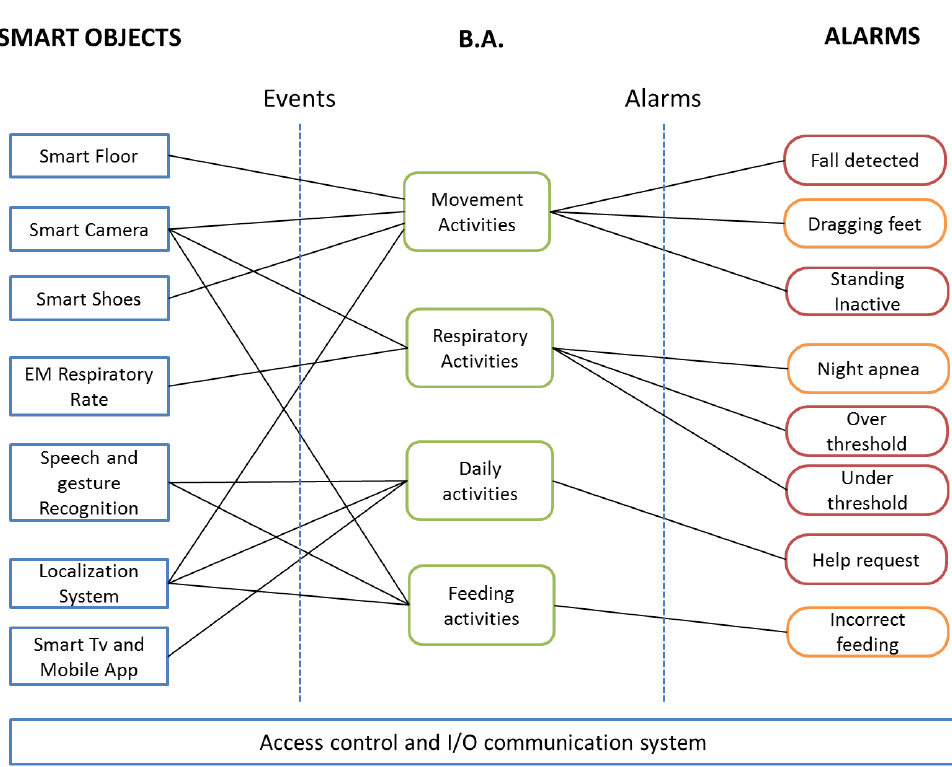
Figure 1. HDOMO logic architecture: 7 different SOs, based on multiple sensors, process data at low level to perform 4 different Behaviour Analyses (B.A.), which are processed at high level in the cloud infrastructure and are able to generate 8 different alarms on two levels: level 1 (critical alarm—red) and level 2 (non critical